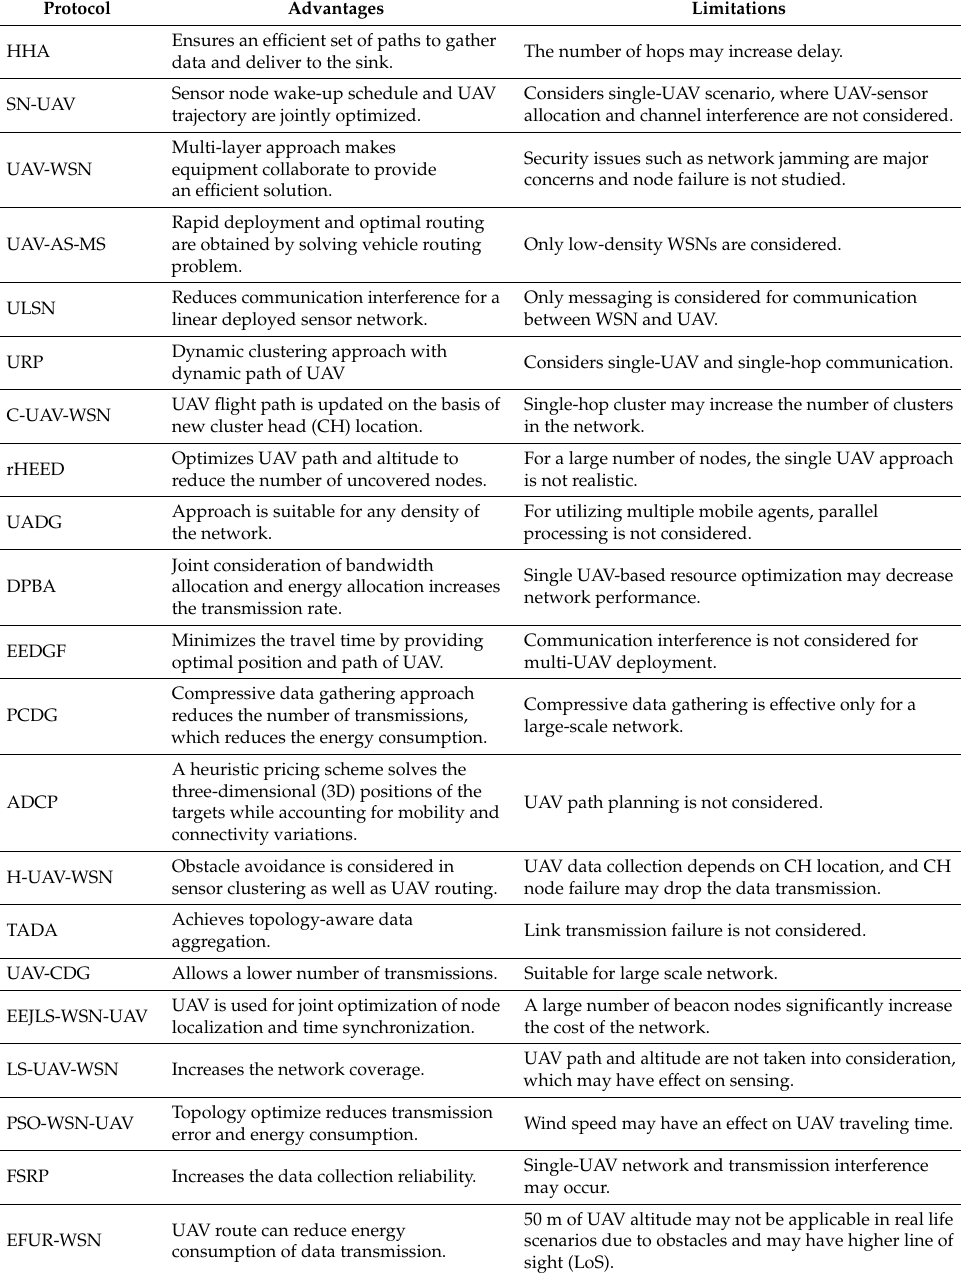
Table 3. Advantages and limitations of the existing routing protocols for